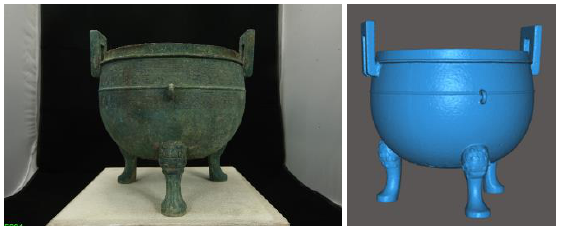
Figure 11: Bronze tripod test